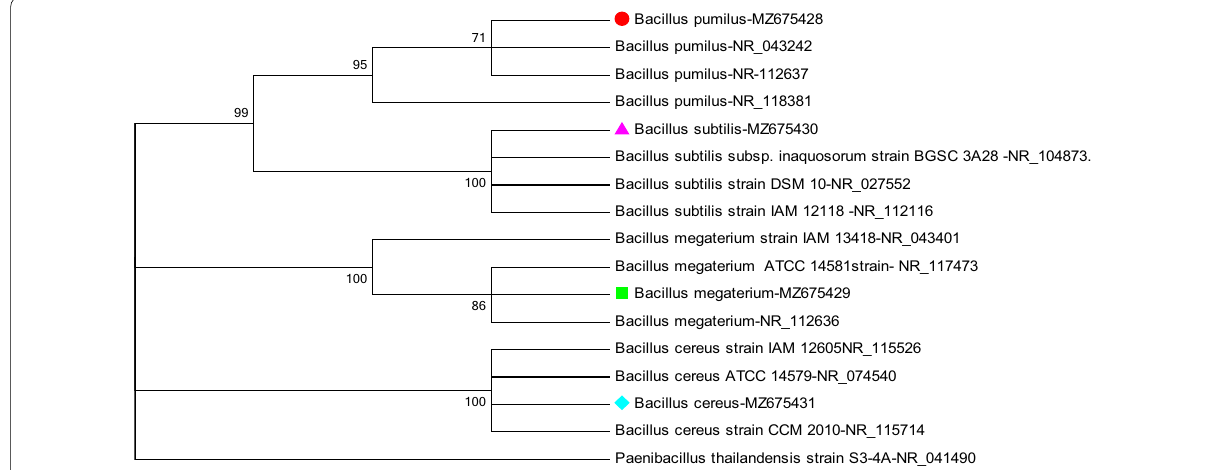
Table 3 Plant growth-promoting characters of rhizobacterial isolates